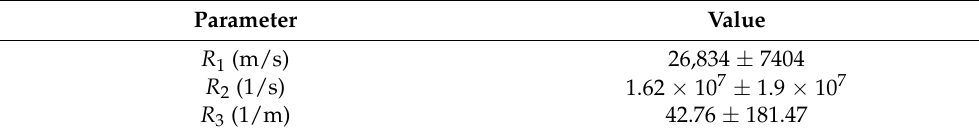
Table 3. Dry layer resistance parameters.